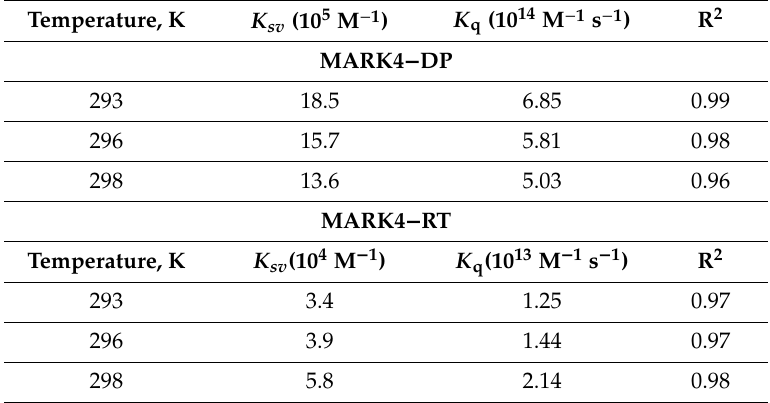
Table 1. Stern − Volmer constants calculated for interactions of MARK4 with DP and RT at di ff erent temperatures.